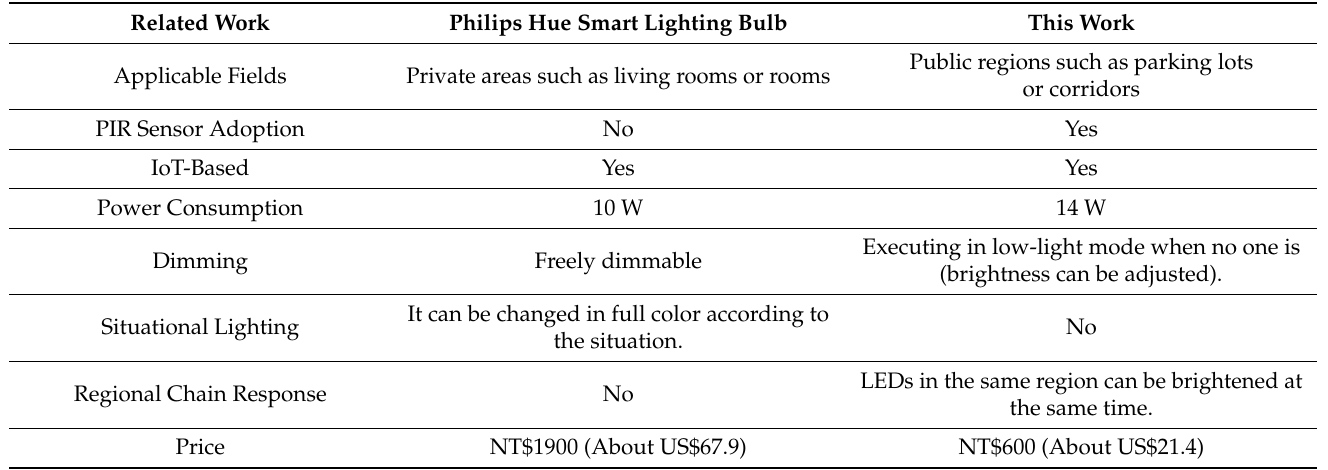
Table 2. A comparison of Philips hue smart lighting full-color situational 10 W bulb [48] with this work.